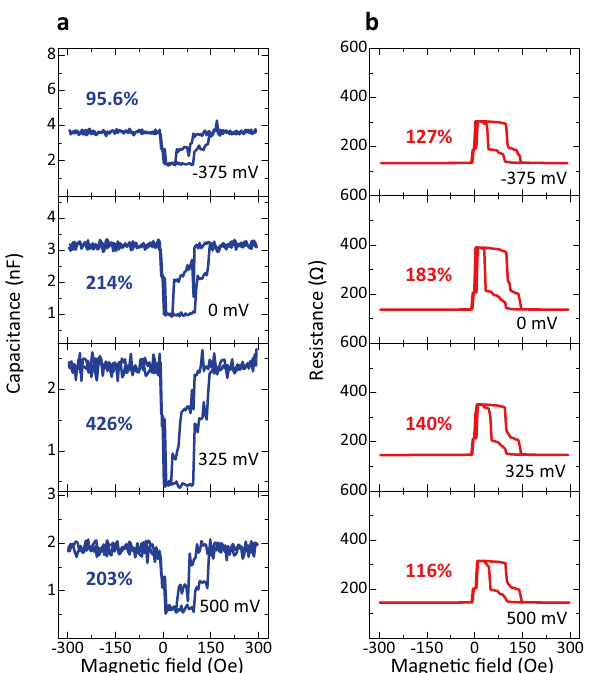
Figure 4. Voltage dependence of TMC and TMR curves. ( a ) TMC curves and ( b ) TMR curves of an Fe/MAO/ Fe MTJ (sample B).